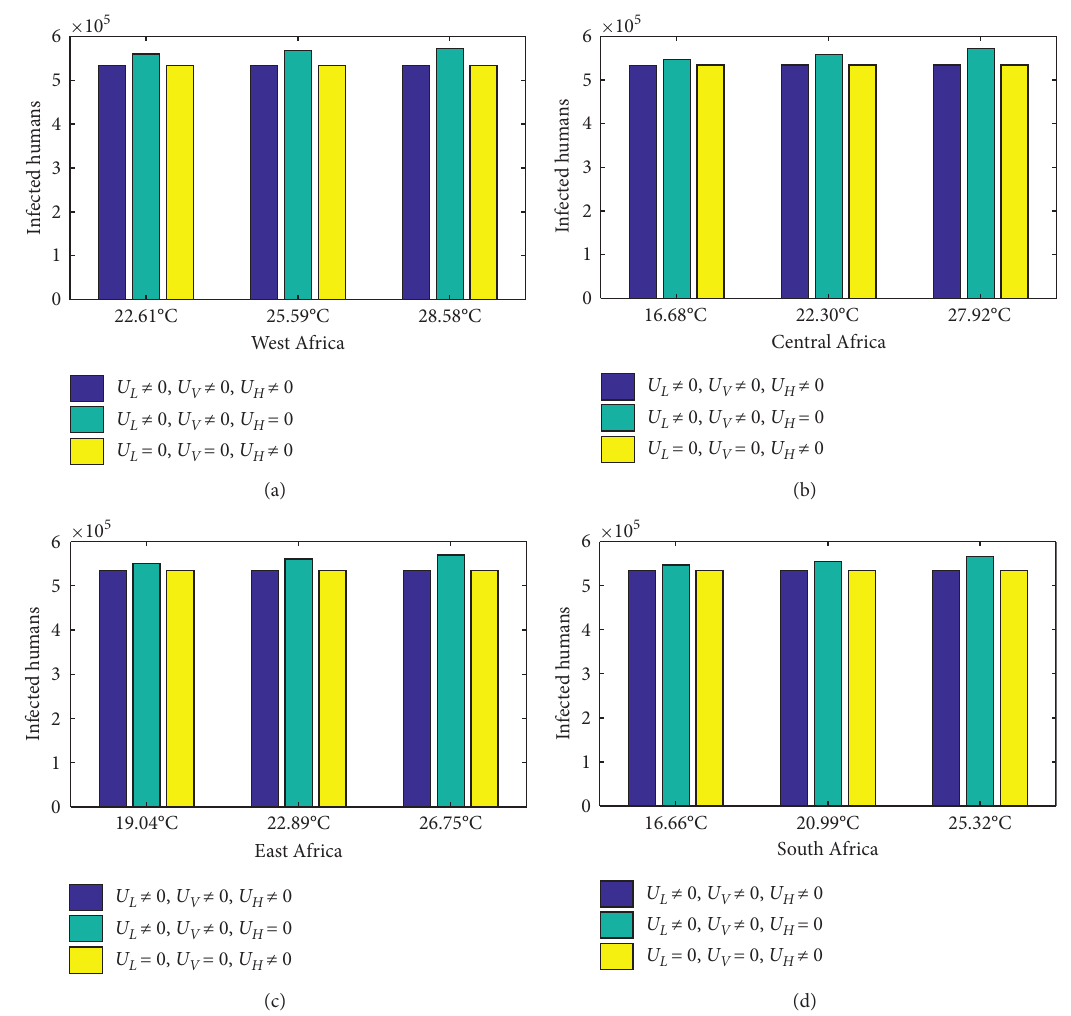
Figure 16: Simulations of the malaria model (2) as a function of time plotting the average control levels for controls u Central, East, and Central